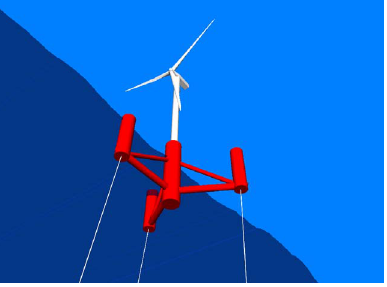
Fig. 1 Configuration of the TLP.